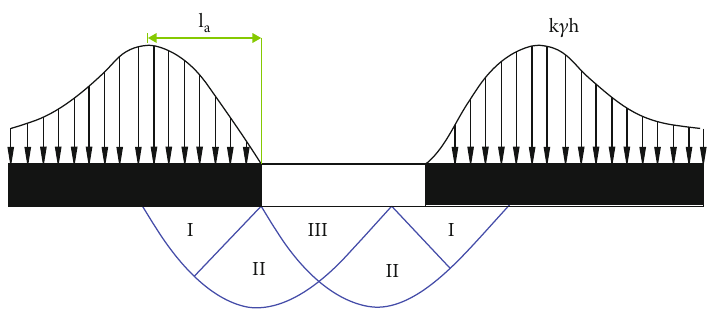
Figure 5: Calculation model of equivalent roadway fl oor failure depth.